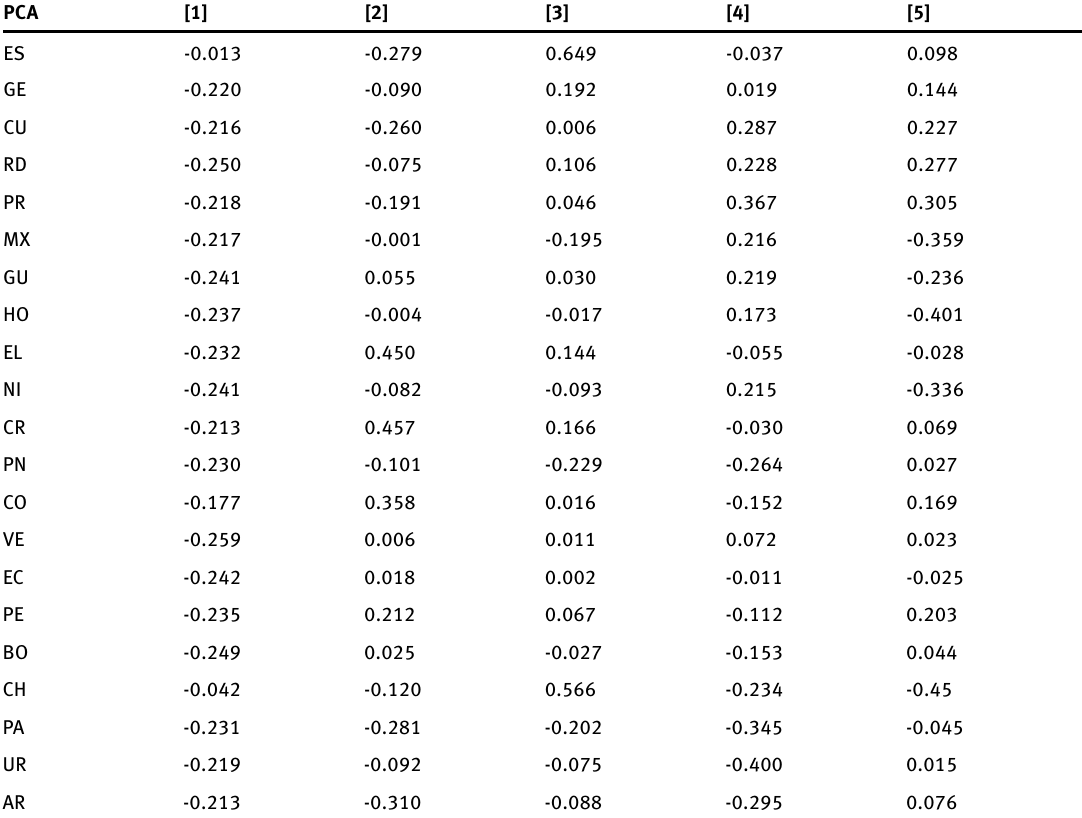
Table 4. Principal component analysis by country in the Varilex-R database. Eigenvalues: 6.645; 1.361; 1.182; 1.145;